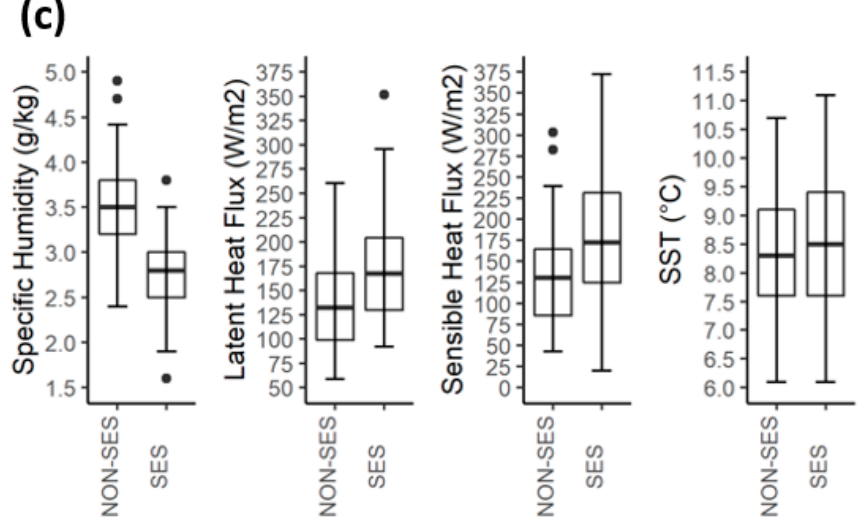
Figure 4. Changes in meteorological parameters in SES and non-SES events at ( a ) point “A”, ( b ) point “B”, and ( c ) point “C” on the western Black Sea surface.